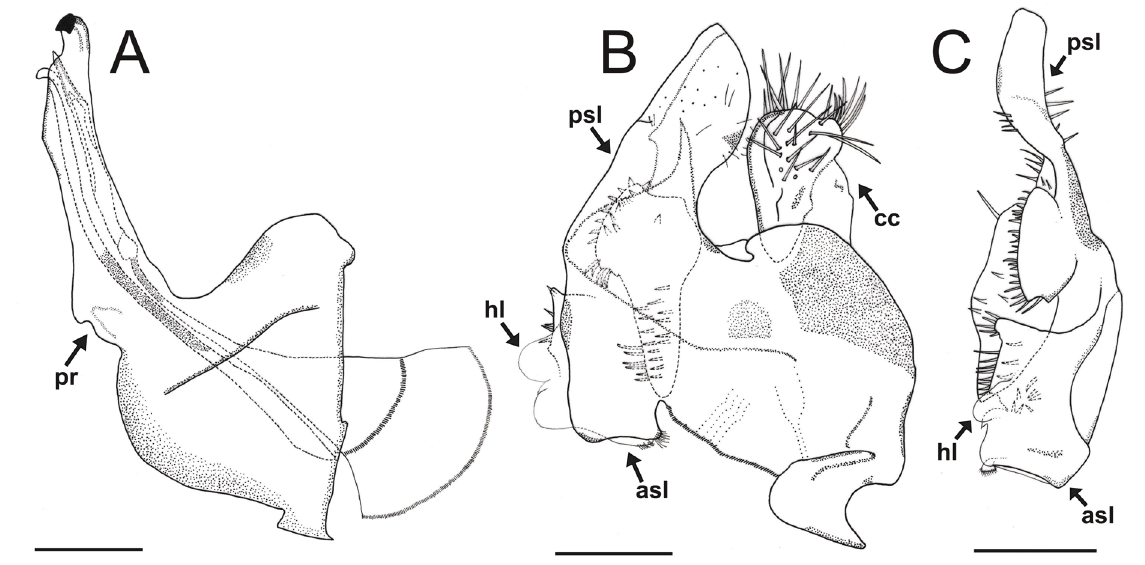
Fig. 7. Eumerus colladoi Ricarte & Aguado-Aranda sp. nov., holotype, ♂ (CEUA-CIBIO), genitalia. A . Hypandrium, lateral view. B . Epandrium, lateral view. C . Epandrium, right side, ventral view. Abbreviations: asl = anterior surstylar lobe; cc = cercus; hl = hyaline lobes; pr = prominence; psl = posterior surstylar lobe. Scale bars: 250